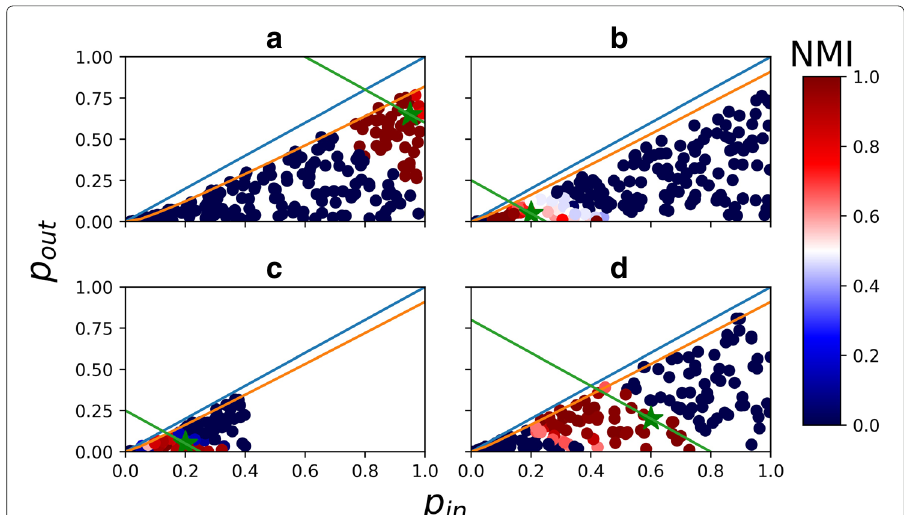
Fig. 3 Learning the parameters of the noisy channel. Each subgraph report results obtained on an artificial network constructed according to a synthetic model similar to the Girvan-Newman benchmark, where N = 128 are divided into Q = 4 communities of equal size. Nodes within the same group are connected with probability ˆ p in , while pairs of nodes belonging to different groups are connected with probability ˆ p out . We (cid:2) (cid:3) ˆ p ˆ p consider four different combinations to generate four different instances of the model. The four in , out different instances of the model are represented in panels a , b , c , and d . Ground-truth values of ˆ p in and ˆ p out are denoted by the green star symbol in the various panels. We apply the method for community detection introduced in this paper to the graph using the parameters values ˜ p in and ˜ p out , randomly sampled in the regime of detectability. The value of the normalized mutual information (NMI) between retrieved and ground-truth community structure is represented by the color of the various points. The green line in the plot identifies combinations of p in and p out compatible with the observed average degree (cid:4) k (cid:5) of the graph. The blue line is y = x , and denotes the region where community structure is present. The orange line is